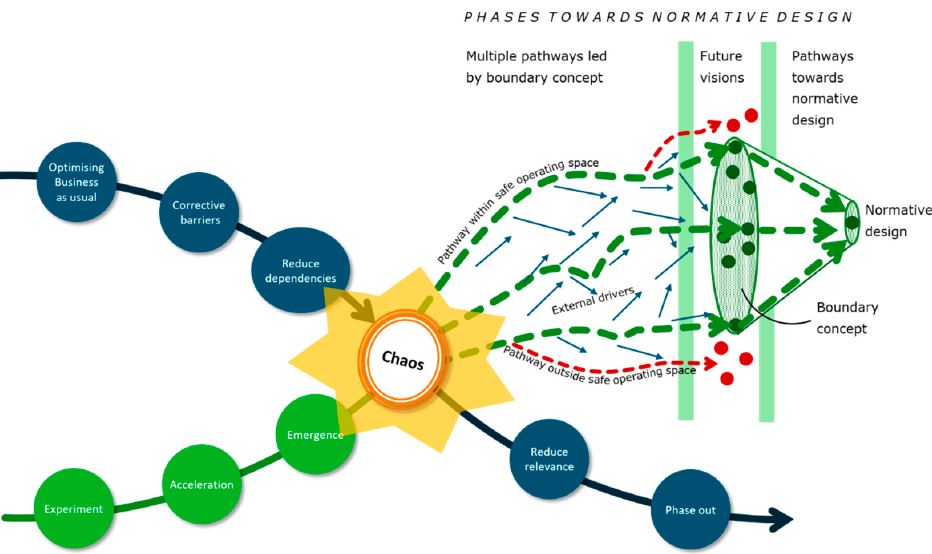
Figure 2. The role of visions as boundary concepts. Several sustainable visions (dark green spots) are comprised of multidimensional target space, whereas unsustainable visions (red dots) are unfeasible. Pathways should be defined—and followed—to arrive within the limits of this space, varying under the influence of external factors, such as climate change and societal changes.